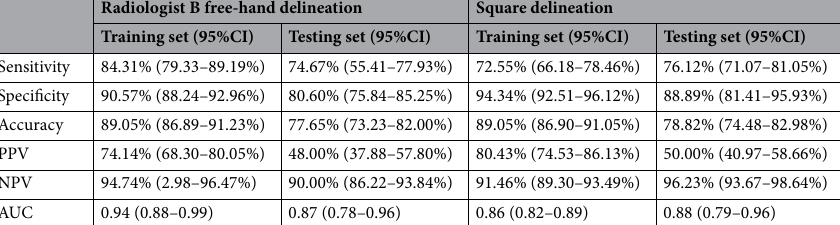
Table 3. Diagnostic performance of fetal-lung-texture analysis, based on free-hand delineation of region of interest by radiologist B and square delineation by radiologist B. CI confidence interval, PPV positive predictive value, NPV negative predictive value, AUC Area under the receiver-operating-characteristics